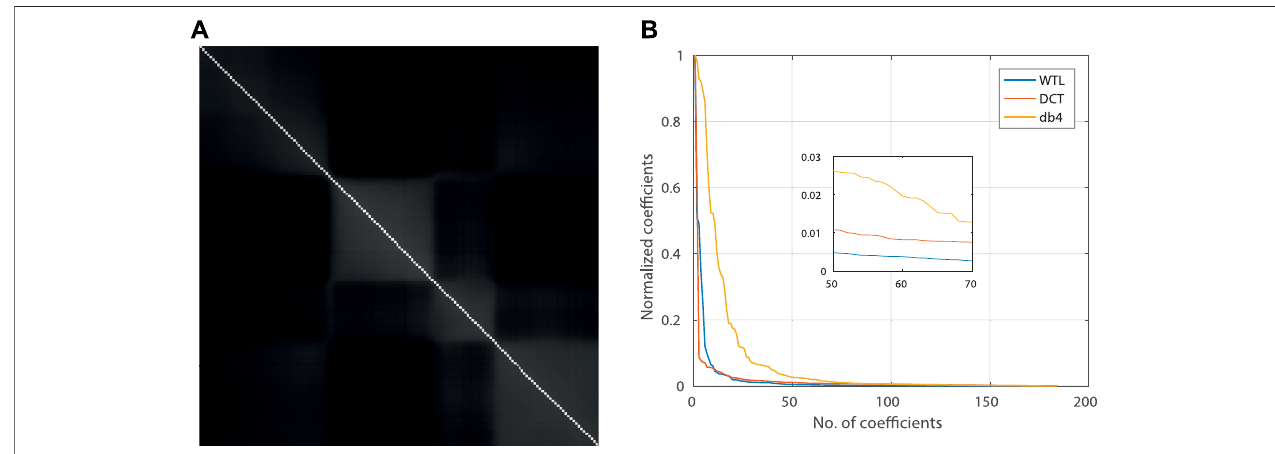
FIGURE 5 | (A) Mutual information (MI) matrix for the data set “ Urban ” : a symmetric matrix with highest value along the diagonal that represents MI between same bands. The proposed WTL-I framework utilizes the MI matrix for the spectral direction. (B) Sparsi fi cation with DCT and the learned wavelet. A sparser signal has faster decayingcoef fi cientssuchthatthemajorityoftotalenergyisaccumulatedinafewernumberofcoef fi cients.Thenormalizedcoef fi cientsareobtainedbynormalizingeach coef fi cient with the maximum-value coef fi cient. Wavelet transform learning (WTL) with the MI matrix for the spectral direction provides more sparsi fi cation than the fi xed DCT and db4 basis. Results are shown for a single pixel along the spectral